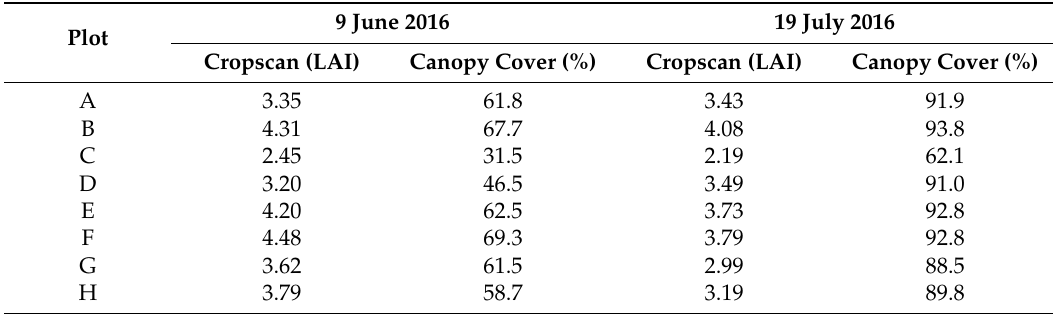
Table 4. Leaf area index based on Cropscan measurements and the canopy cover during the two measurement days.